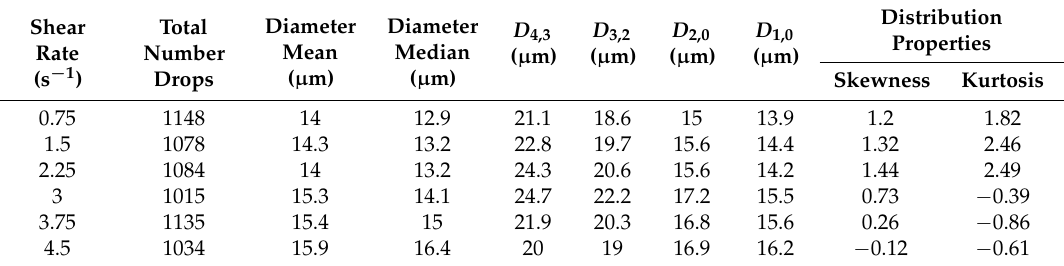
Table 1. Drop size distribution statistics for the histograms shown in Figure